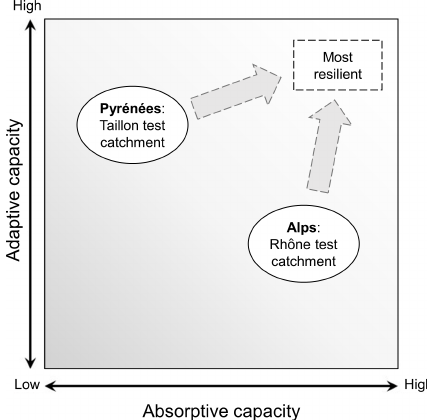
Figure 4. Regional comparisons of hydrological resilience. Two test catchments are compared, including the Taillon–Gabiétous catch- ment in the French Pyrénées and the Rhône catchment in the Swiss